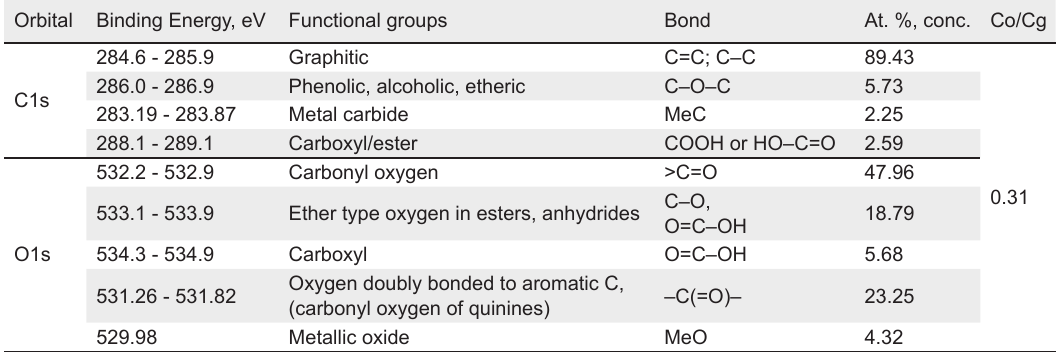
Table 2. High-resolution C1s and O1s XPS spectral peaks of the primary activated